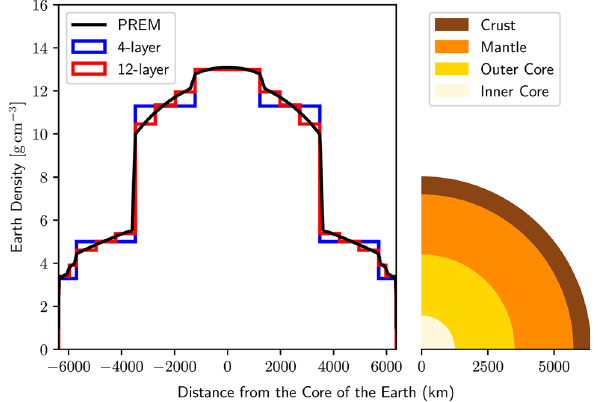
Fig. 1 Earth density profile, according to the Preliminary Reference Earth Model (PREM) and its approximation by 4- and 12-layers of constant density (commonly called PREM4 and PREM12, respec- tively) [14]